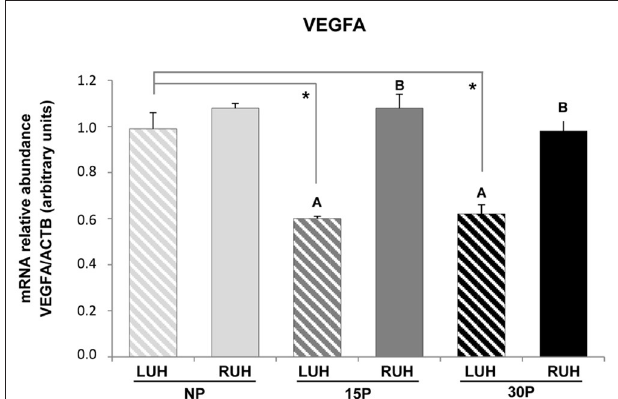
FIGURE 5 | Relative abundance of VEGFA mRNA in the endometrium of non-pregnant (NP), 15 days-pregnant (15P), and 30 days-pregnant (30P) alpacas by RT-PCR. Histograms illustrate mean values ± SE. Different uppercase letters (A,B) indicate significant differences between LUH (left uterine horn) and RUH (right uterine horn) within NP, 15P, and 30P status ( p < 0.05 ). Asterisks indicate significant differences (* p < 0.05 ) between the physiological